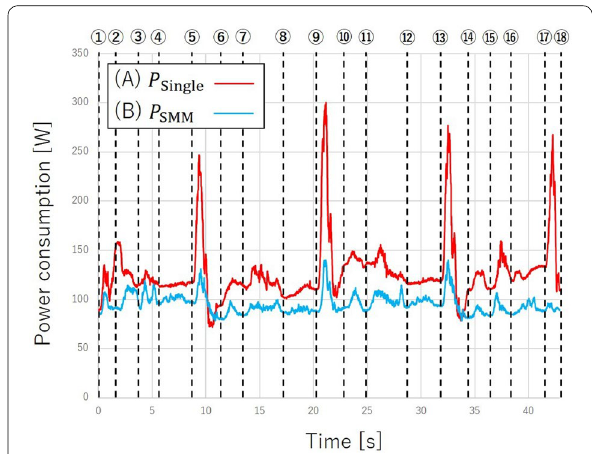
Fig. 14 Power consumption P { Single,SMM } in one cycle (Phase1– Phase18)